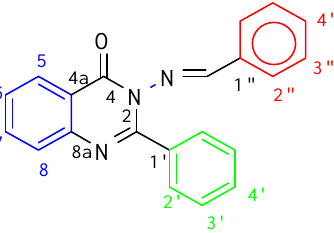
Figure 1. Juxtaposed pictures of the 2D-NMR spectra of compound 3j